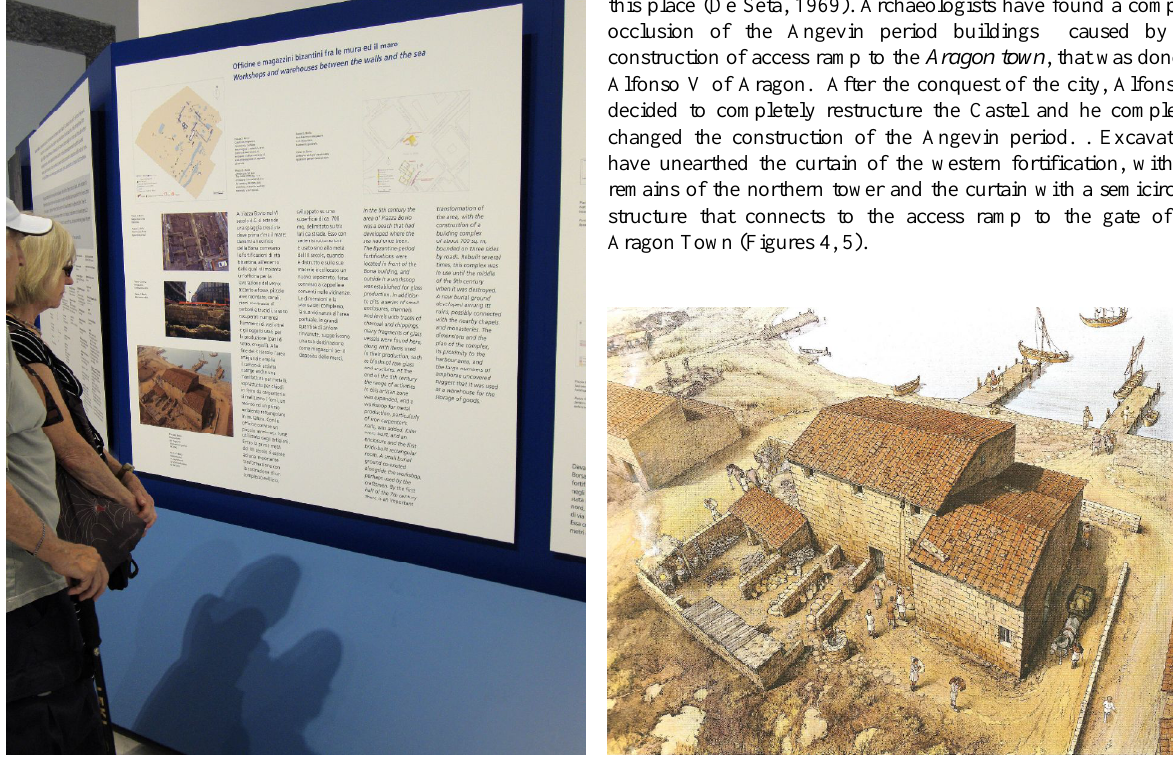
Figure 10: Napoli, Museo Nazionale, exhibition “Naples, city and sea” . The additional information into written form determines a communication stress.